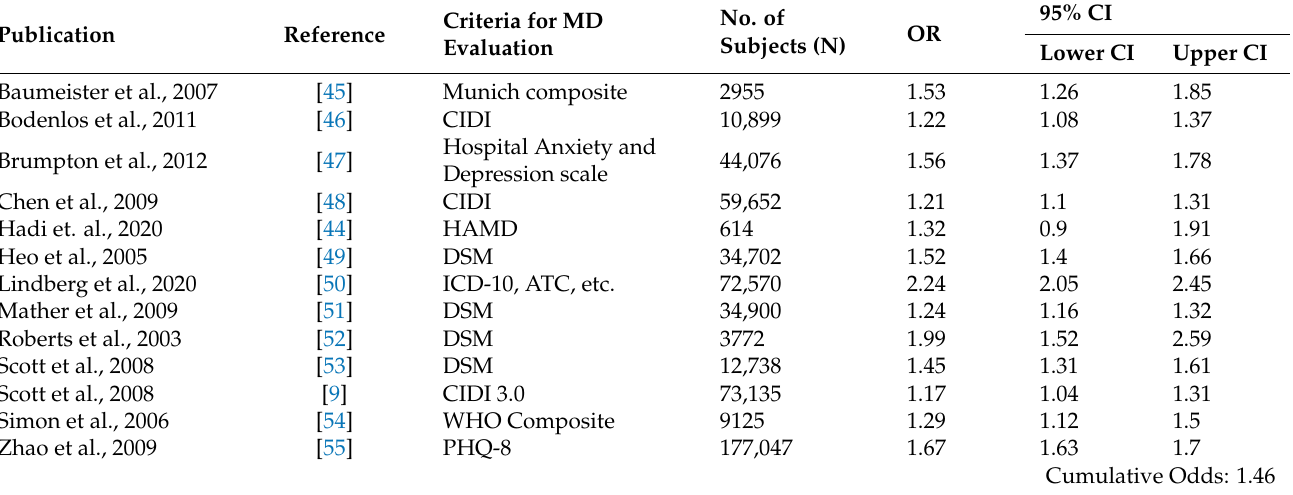
Table 1. Population data of included